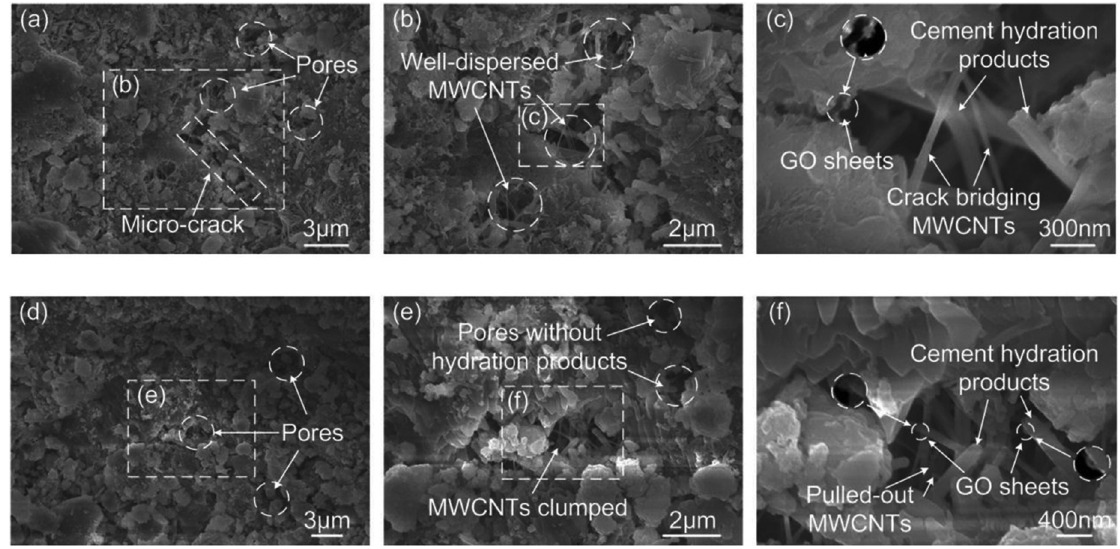
Figure 9: SEM images of GO/MWCNT - OPC pastes: ( a – c ) Sample G/M - 1; ( d – f ) Sample G/M - 3 [ 107 ]